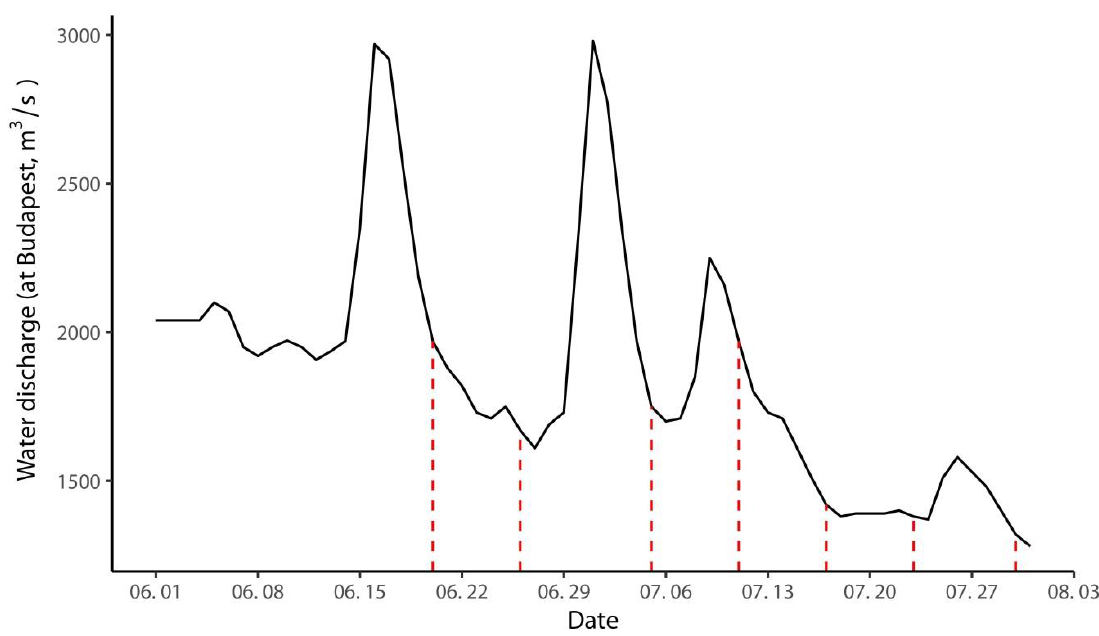
Figure 3. Water discharge measured at Budapest during the study period. Red dotted lines indicate water discharge values on the days of samplings.